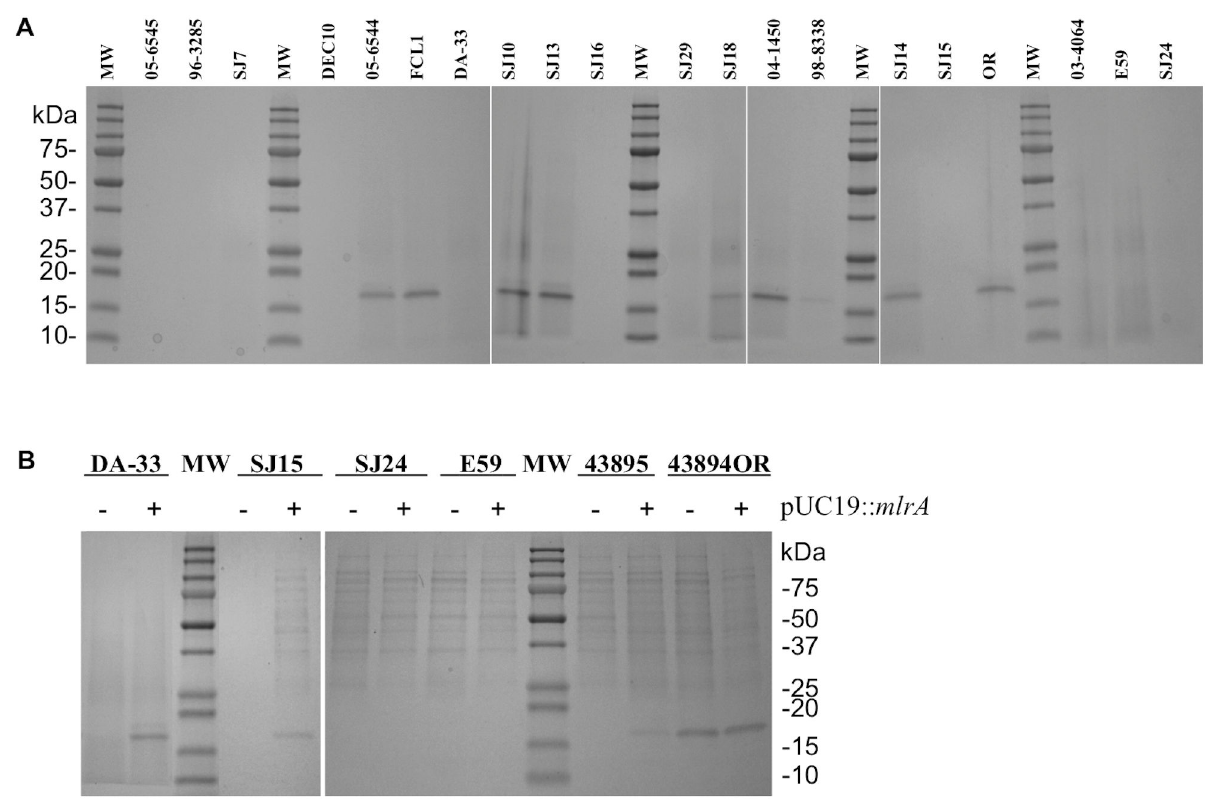
Figure 3. SDS-PAGE of CsgA (curli) extractions. (A) from parent strains and (B) from mlrA mutant strains complemented with pUC19:: mlrA plasmid (+). Strain 43894OR was used as positive control. MW: Precision Plus dual color protein standards (Bio-Rad).